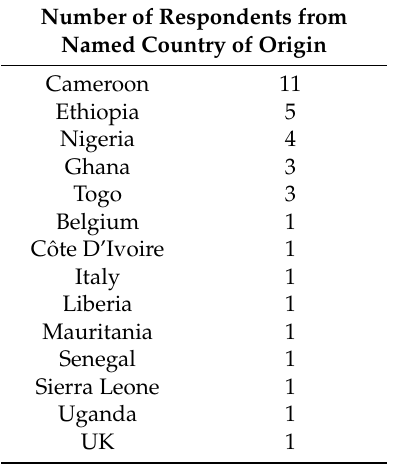
Table 7. First-Generation African Respondents ( n = 35).